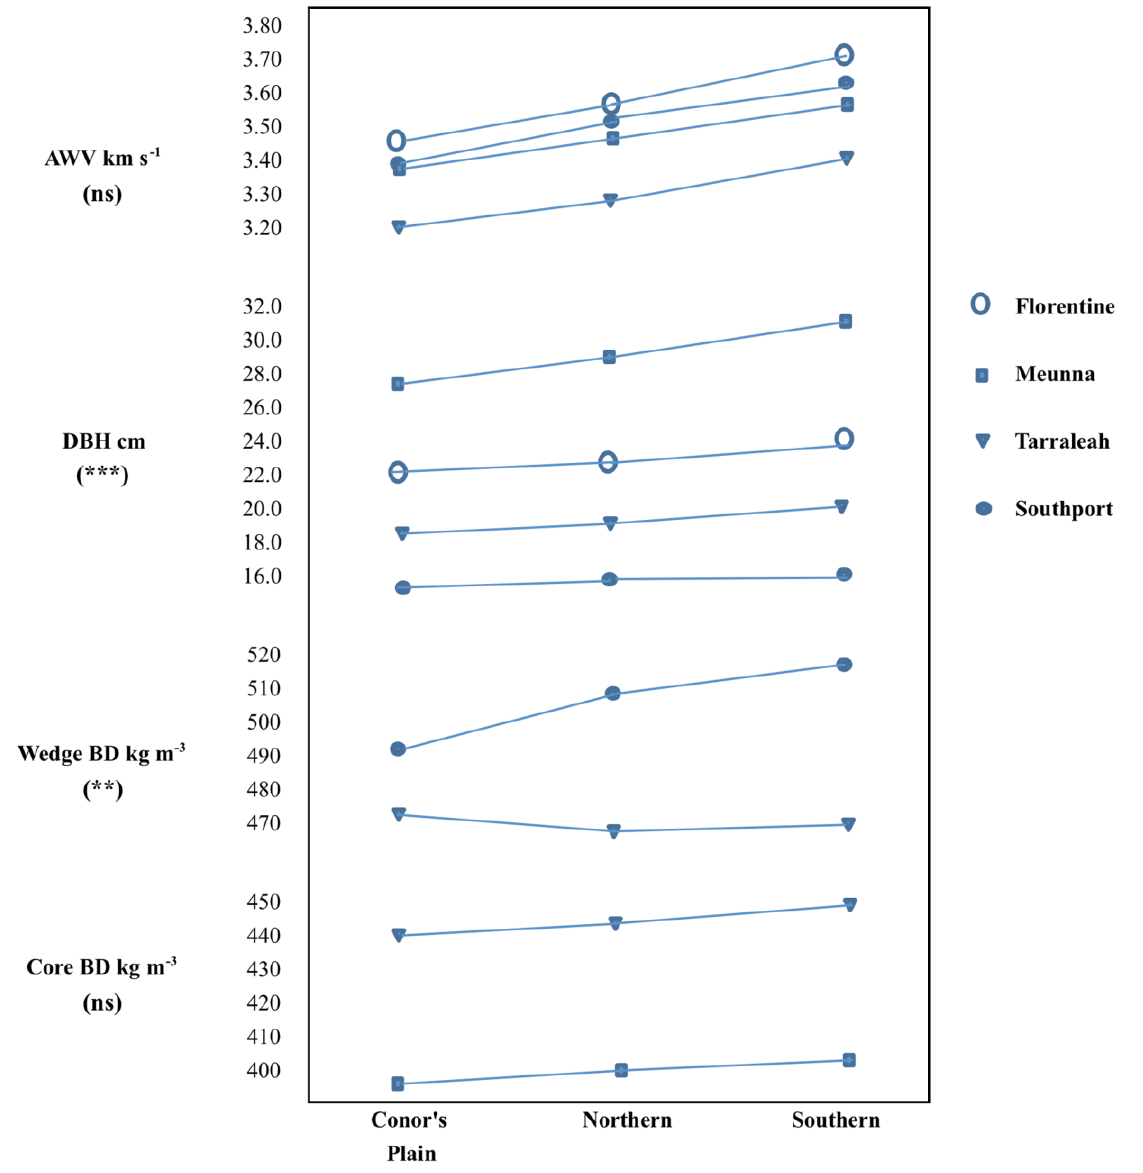
Figure 2. Race means at the four trial sites for acoustic wave velocity (AWV), basic density (BD) and diameter at breast height (DBH; 1.3 m). Some traits were assessed at different ages across sites (see Table 1). The significance of the race by site interaction effect is shown in parenthesis ( ns not significant, * p < 0.05, ** p < 0.01, *** p <